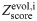
Distributions of the conservation measure Zscoreevol,i obtained for the selected key position residues (red), and all other residues (blue).The lower and upper "hinges" of the box correspond to the first and third quartile, and the black band inside the box is the median (Second quartile). The violin plot under the box plot shows the distribution of a given variable.